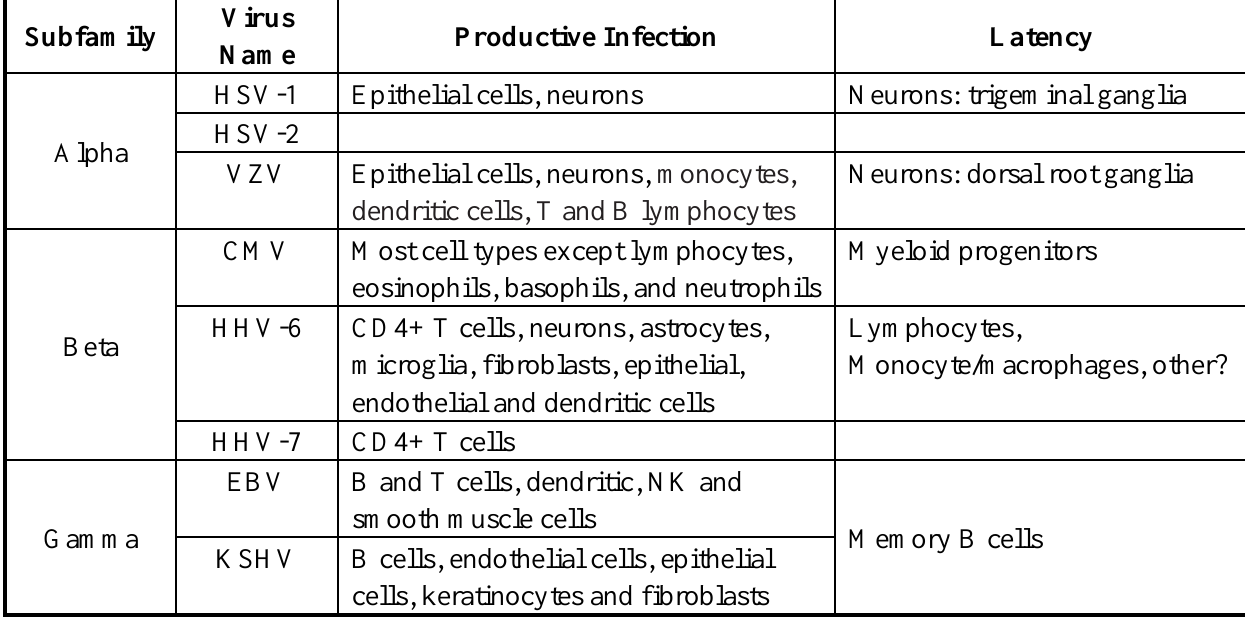
Table 2. Human herpesviruses and permissive cell